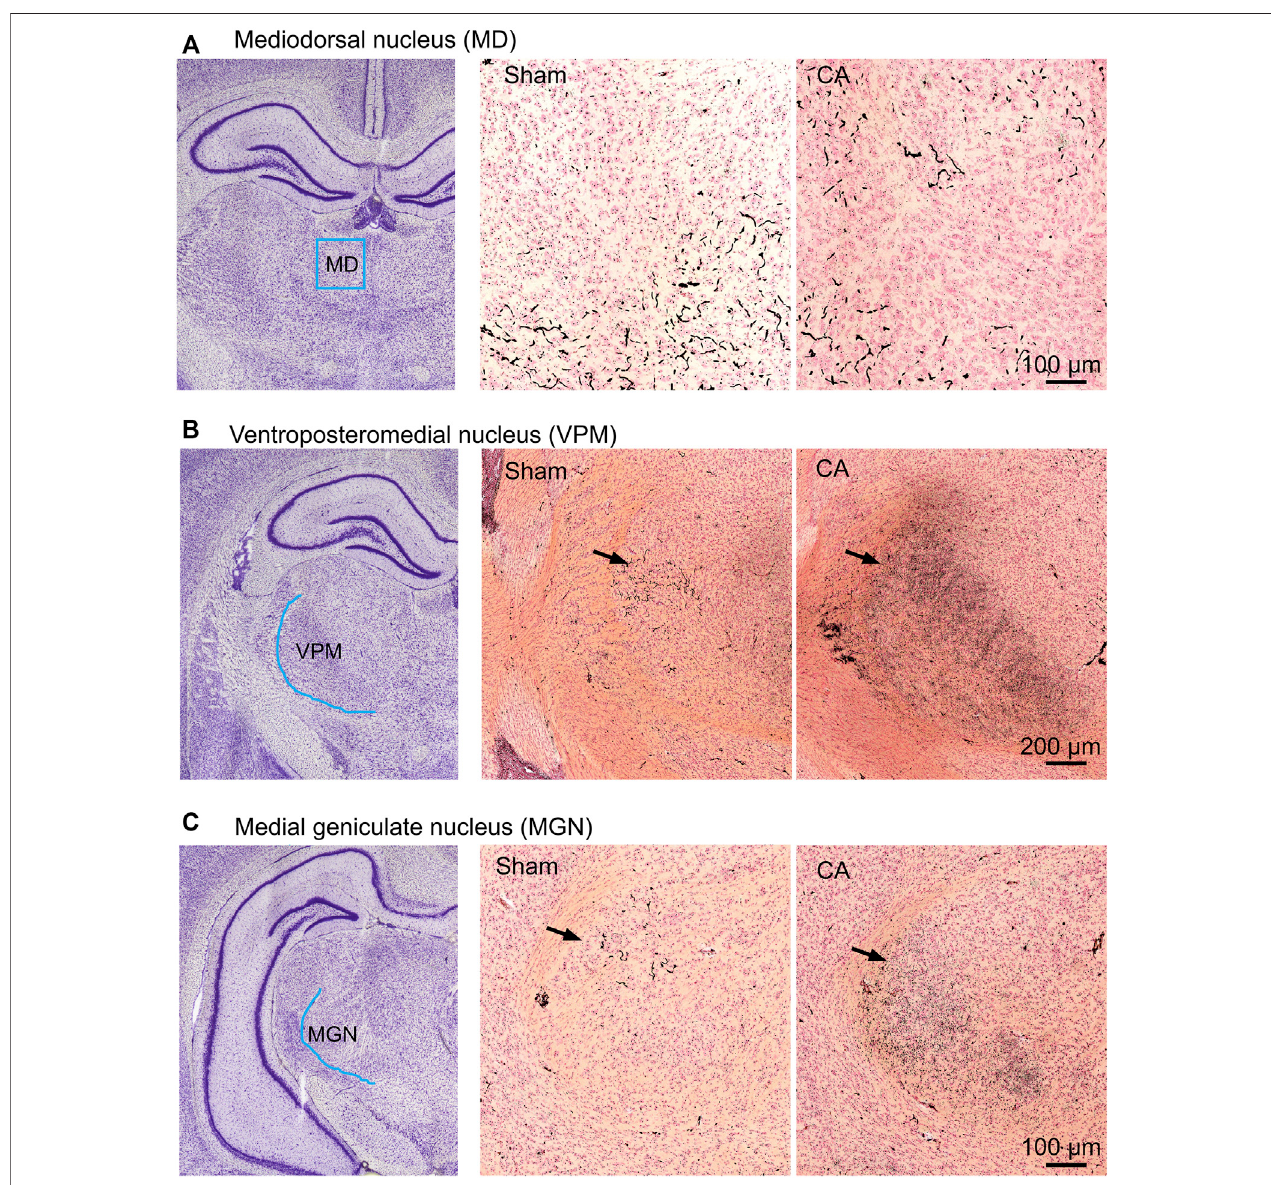
FIGURE 7 | CA-induced synaptic degeneration in sub-areas of thalamic relays. The ROI scheme (left) , CuAg stain in sham (middle) and 12.5 min cardiac arrest (right) inthemediodorsalthalamicnucleus (A) ,ventroposteriomedial (B) ,andmedialgeniculatethalamicnucleus (C) .Notethatthedegeneratingsynapseswereseenin both VPM and MGN but not in MD of injured